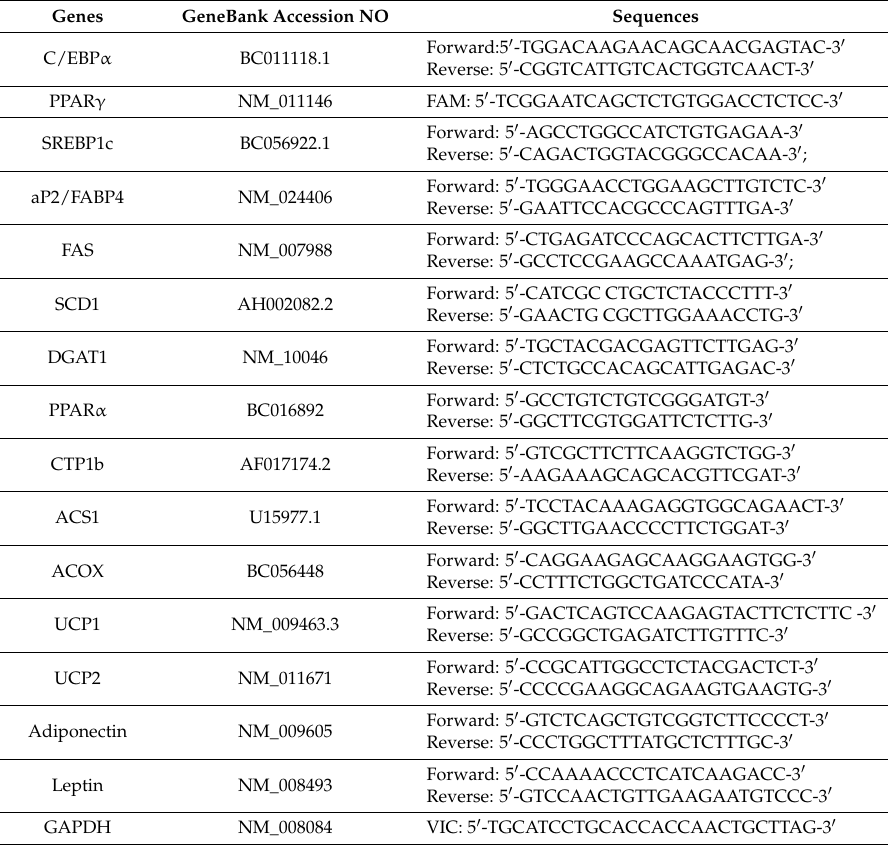
Table 1. Oligonucleotide and probe